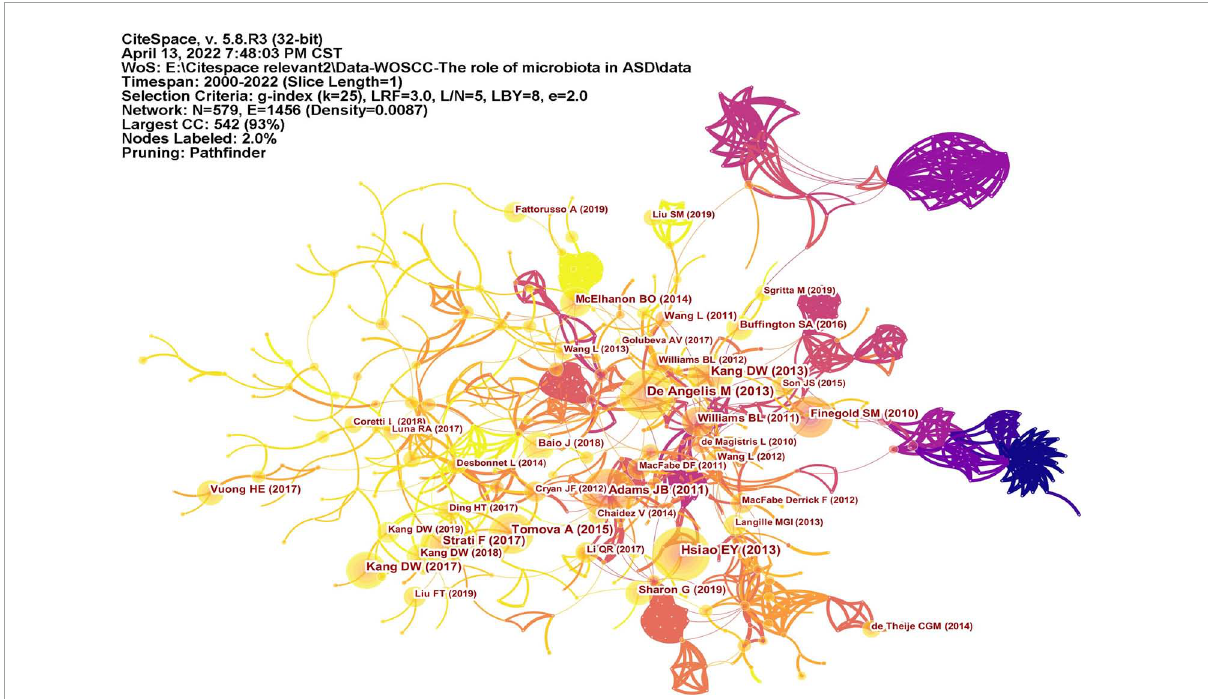
FIGURE10 The network of co-cited references. Lines represent articles by two authors were jointly cited by an article. The darker the color, the more times the author’s articles are cited.